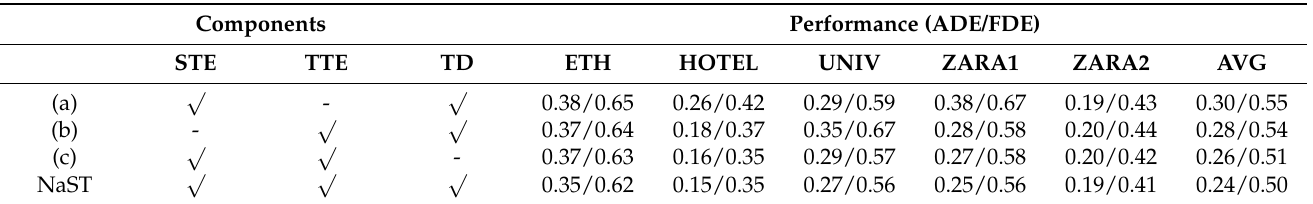
Table 2. Ablation Study on ETH and UCY datasets of ADE/FDE metrics (the lower numerical result is